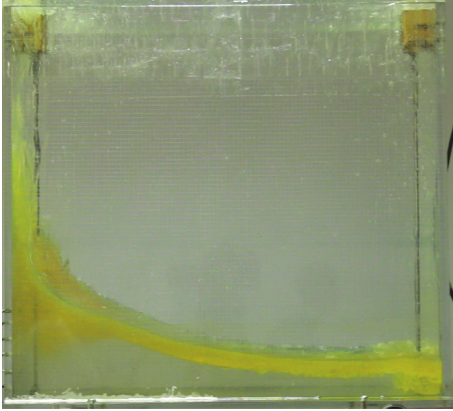
Figure 8: Diesel oil-water mixture at liquid